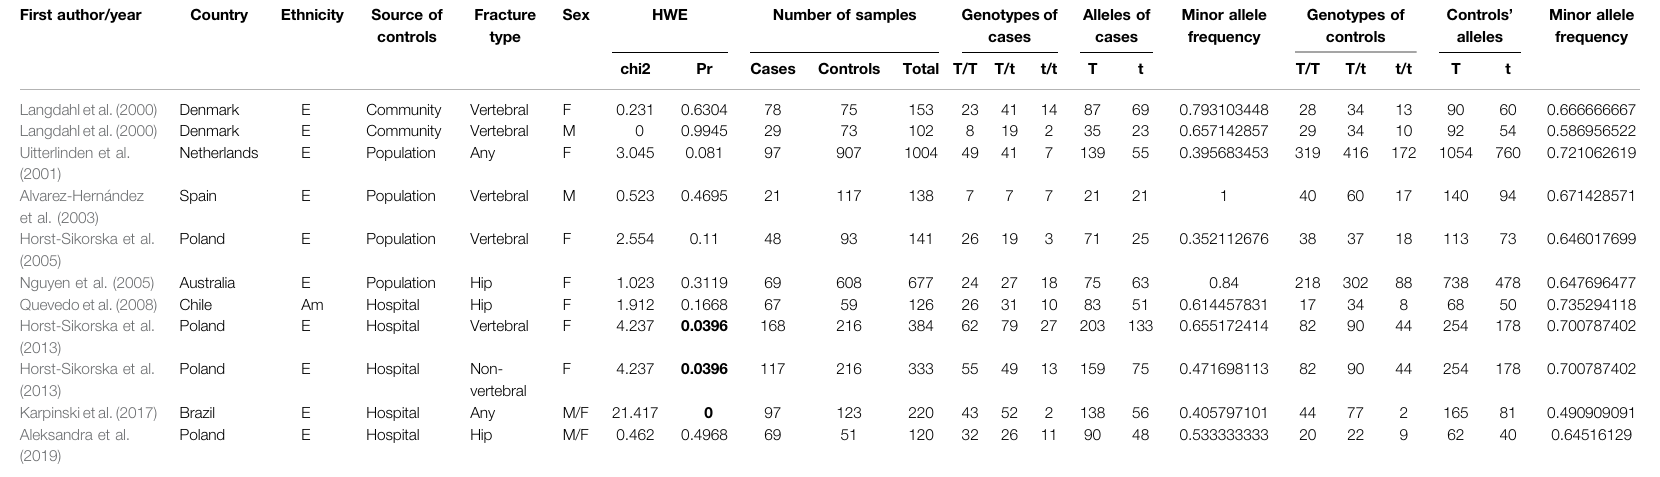
TABLE 4 | Genotype frequencies of VDR TaqI polymorphism in studies included in this